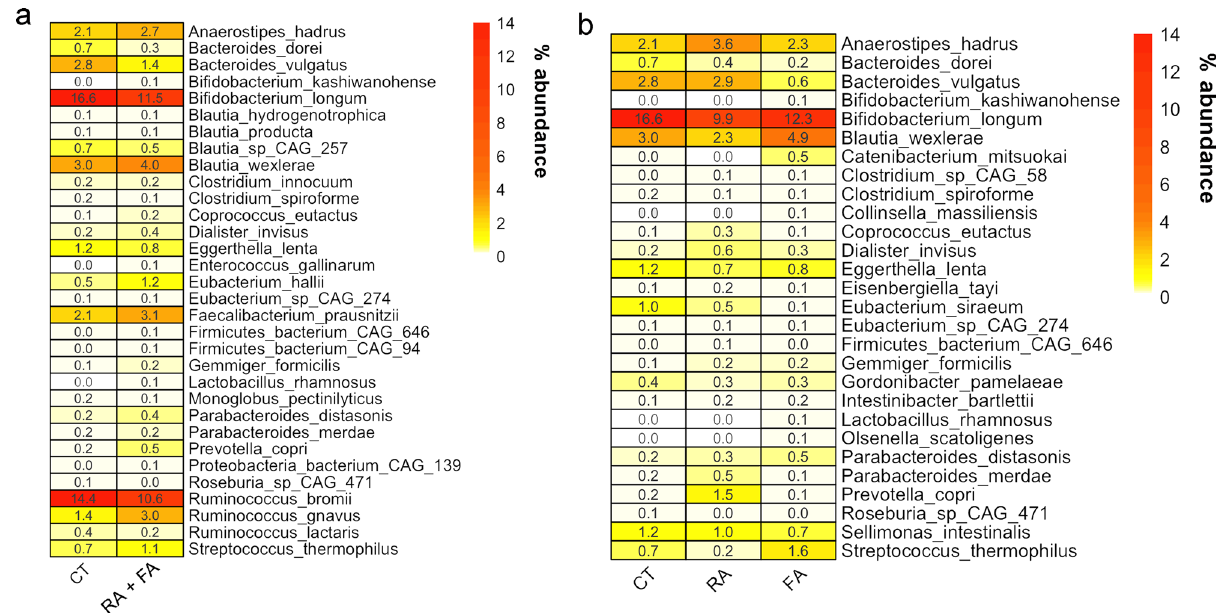
Fig. 1 Microbial signatures in allergic children gut microbiome. Heatplot reporting the average relative abundance (%) of microbial taxa signi fi cantly different between healthy (CT) and allergic children ( a ) or healthy children (CT) and children with food (FA) or respiratory (RA) allergies ( b ), as de fi ned by Wilcoxon test (FDR q < 0.1).